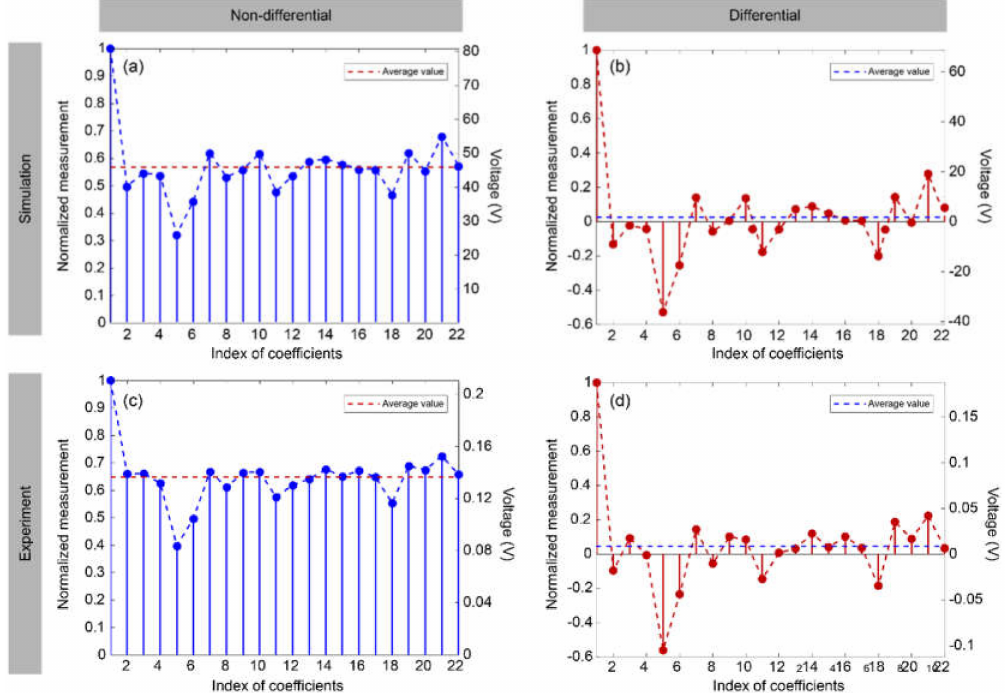
Figure 11. Example of simulation single-pixel measurements and experiment single-pixel measurements.